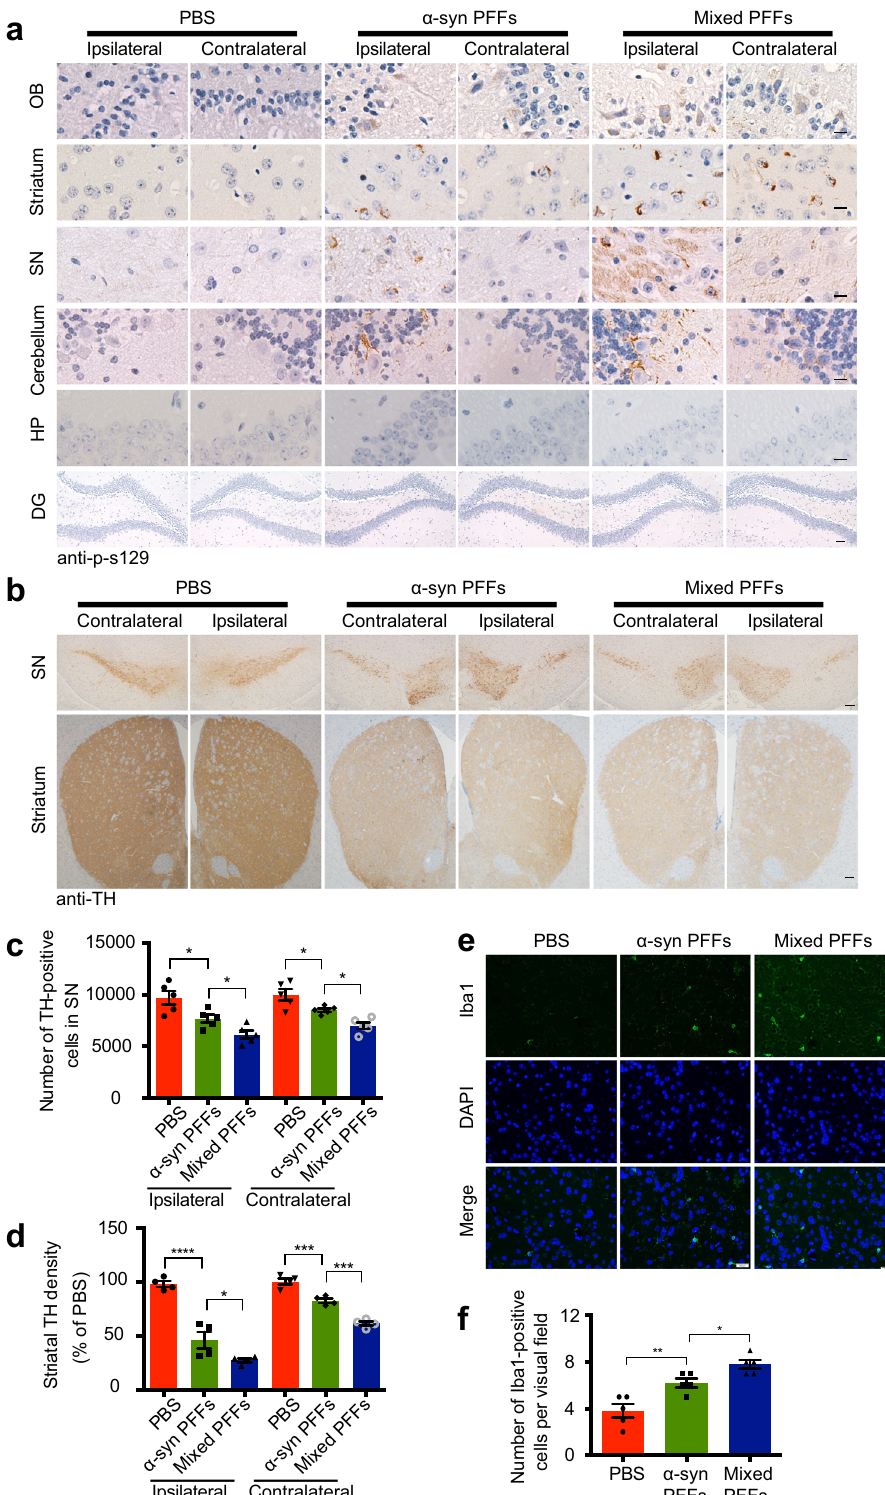
Fig. 2 The mixed fi brils are more prone to transmission in mouse brain. a Immunohistochemistry showing the expression of p-S129 α - synuclein in different brain areas from mice injected with PBS, α -synuclein PFFs, and mixed PFFs. Scale bar in DG area, 50 μ m. Scale bars in other areas, 20 μ m. b – d Immunostaining of TH in the striatum and substantia nigra (SN). Unbiased stereological cell counts in the SN and total density of striatal dopaminergic terminals show that mixed fi brils induced more severe dopaminergic neuronal loss compared with pure α -synuclein fi brils. Scale bars, 100 μ m. Bar graph, quanti fi cation of the TH-positive neurons in the SN and TH density in the striatum. Data are mean ± SEM; n = 4 – 5; * P < 0.05, *** P < 0.001, **** P < 0.0001 by one-way ANOVA. ( e , f ) Immunostaining showing the Iba1-positive microglia in the striatum of mice injected with PBS, α -synuclein PFFs, and mixed PFFs. Scale bar, 20 μ m. Data are mean ± SEM; n = 5; * P < 0.05, ** P < 0.01 by one-way